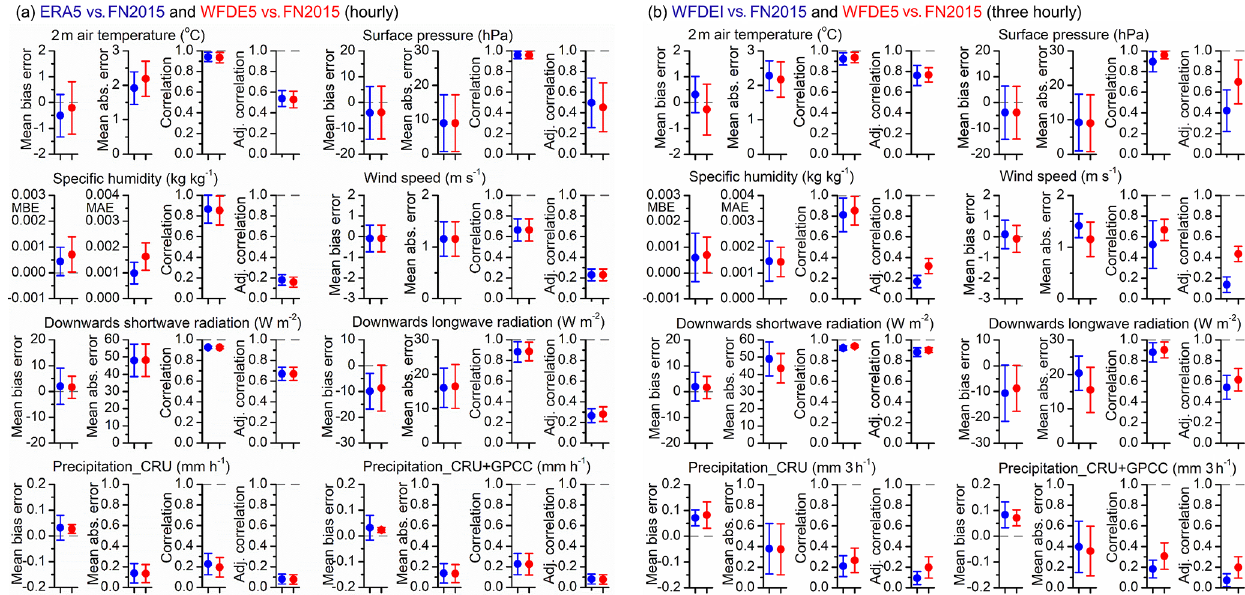
Figure 2. Average metrics (mean ± 95% confidence interval of the mean) for (a) ERA5 versus FN2015 (blue) and WFDE5 versus FN2015 (red) at hourly time steps (see Table A17); (b) WFDEI versus FN2015 (blue) and WFDE5 versus FN2015 (red) at three-hourly time steps (see Table A18).